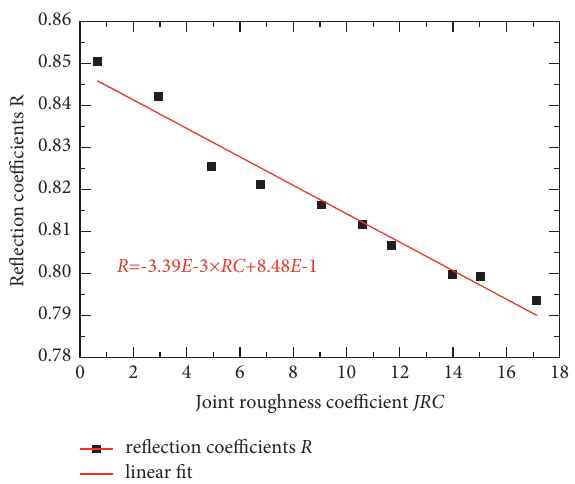
Figure 7: The variation of reflection coefficient with JRC of